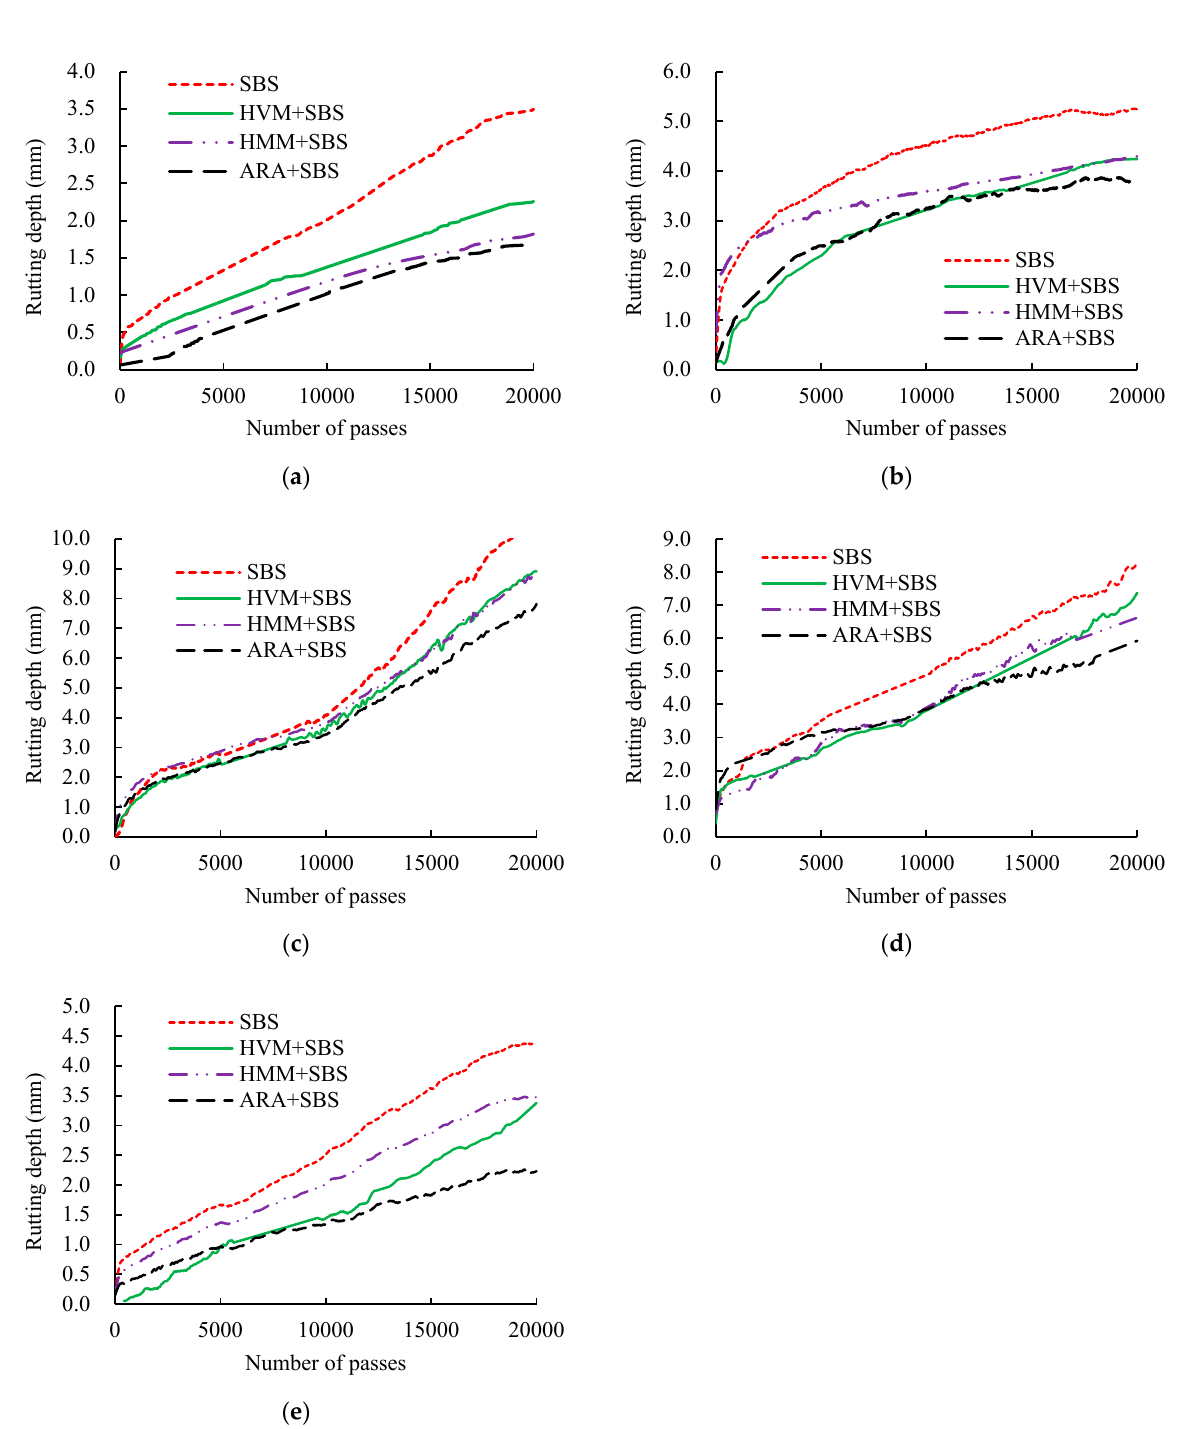
Figure 7. Deformation curve: ( a ) unaged stage, ( b ) short-term aging stage, ( c ) 5-day-long-term aging stage, ( d ) 10-day-long-term aging stage, ( e ) 15-day-long-term aging stage.